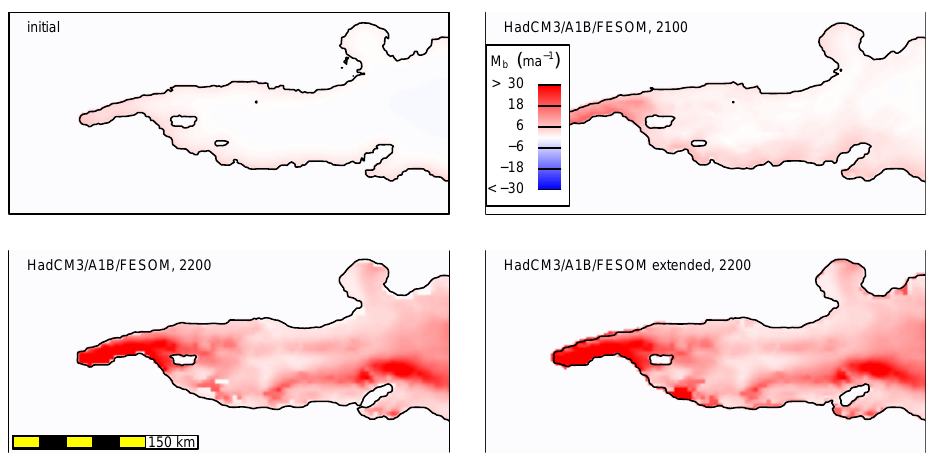
(x,y,t = 1982 ) and HadCM3/A1B/FESOM melt rates M b (x,y,t) for the years 2100 and 2200. Figure 3. Initial melt-rate distribution M 0 b M 0 (x,y,t) is computed from Eq. (9) to maintain elevated melt rates close to the grounding line. Time-dependent melt M b (x,y,t) rates b (x,y,t) . The HadCM3/A1B/FESOM-extended are computed by adding anomalies, computed with respect to the 1980–1990 mean, to M 0 b melt-rate anomalies are constructed as the ice sheet evolves by extrapolating the HadCM3/A1B/FESOM data into floating regions outside the present-day ice shelf.